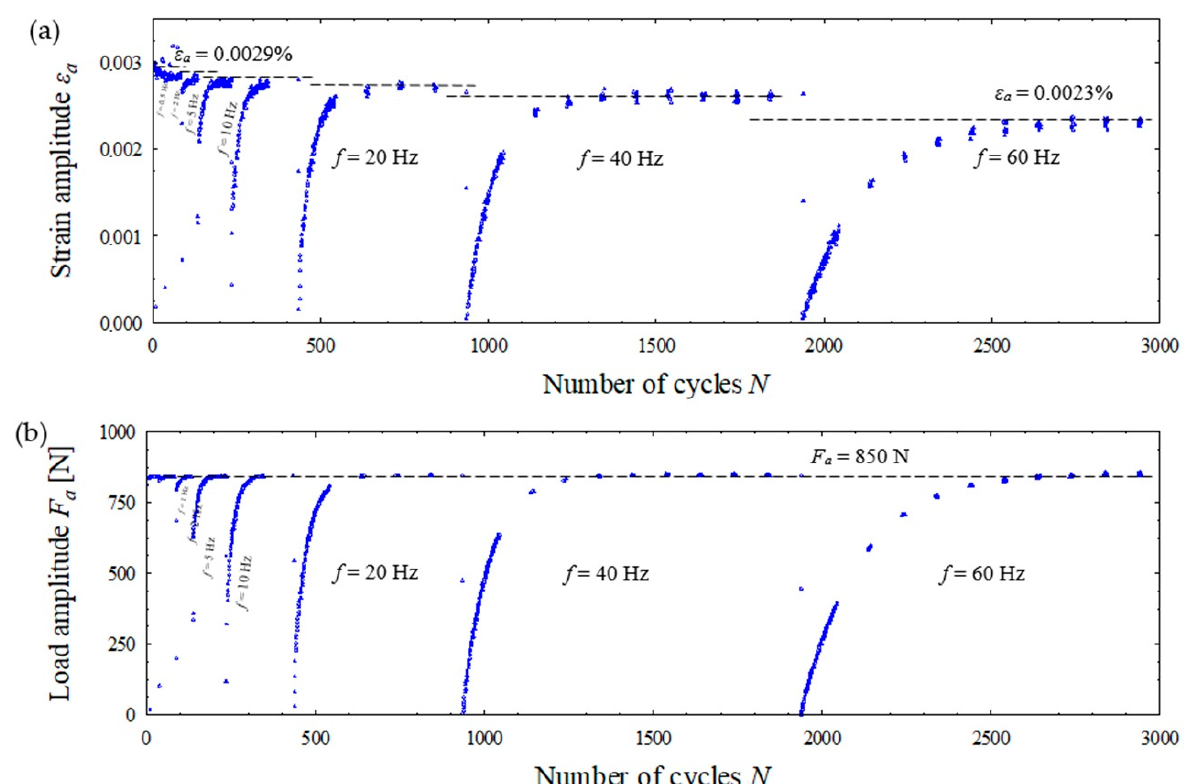
Figure 14. Experimental data obtained during the dynamic loading of the sample 2/46 at different loading frequencies f : ( a ) strain amplitude ε a ; ( b ) load amplitude F a